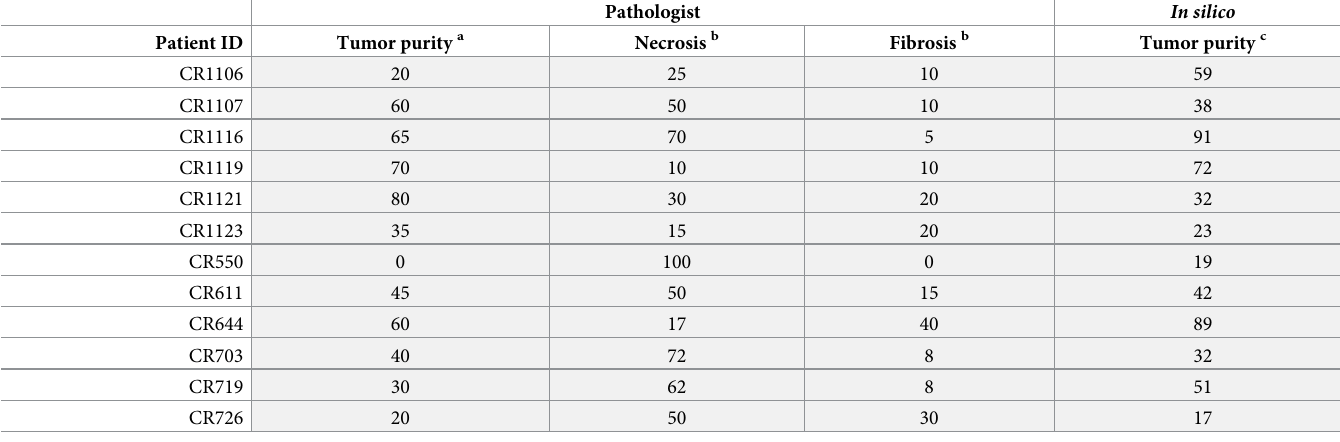
Table 2. Pathologist estimate of tumor purity based on H&E stained sections of FFPE CRCLM tumor samples from 12 patients.